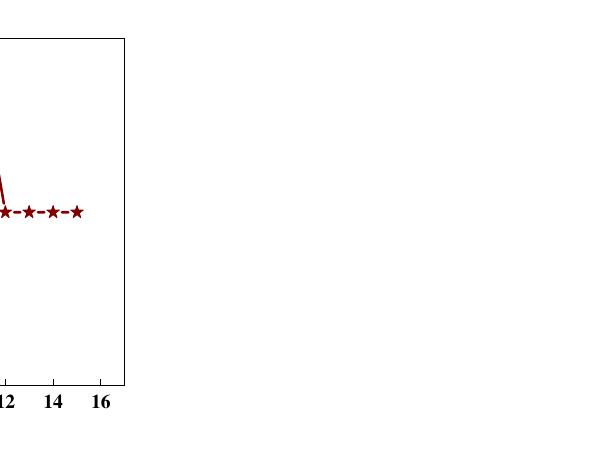
Figure 7. Representative snapshots of storage capacity of Isatin guest molecules inside a single capped SWCNT (10,10) host at various simulation times. For clarity, the water molecules have been omitted from the image.